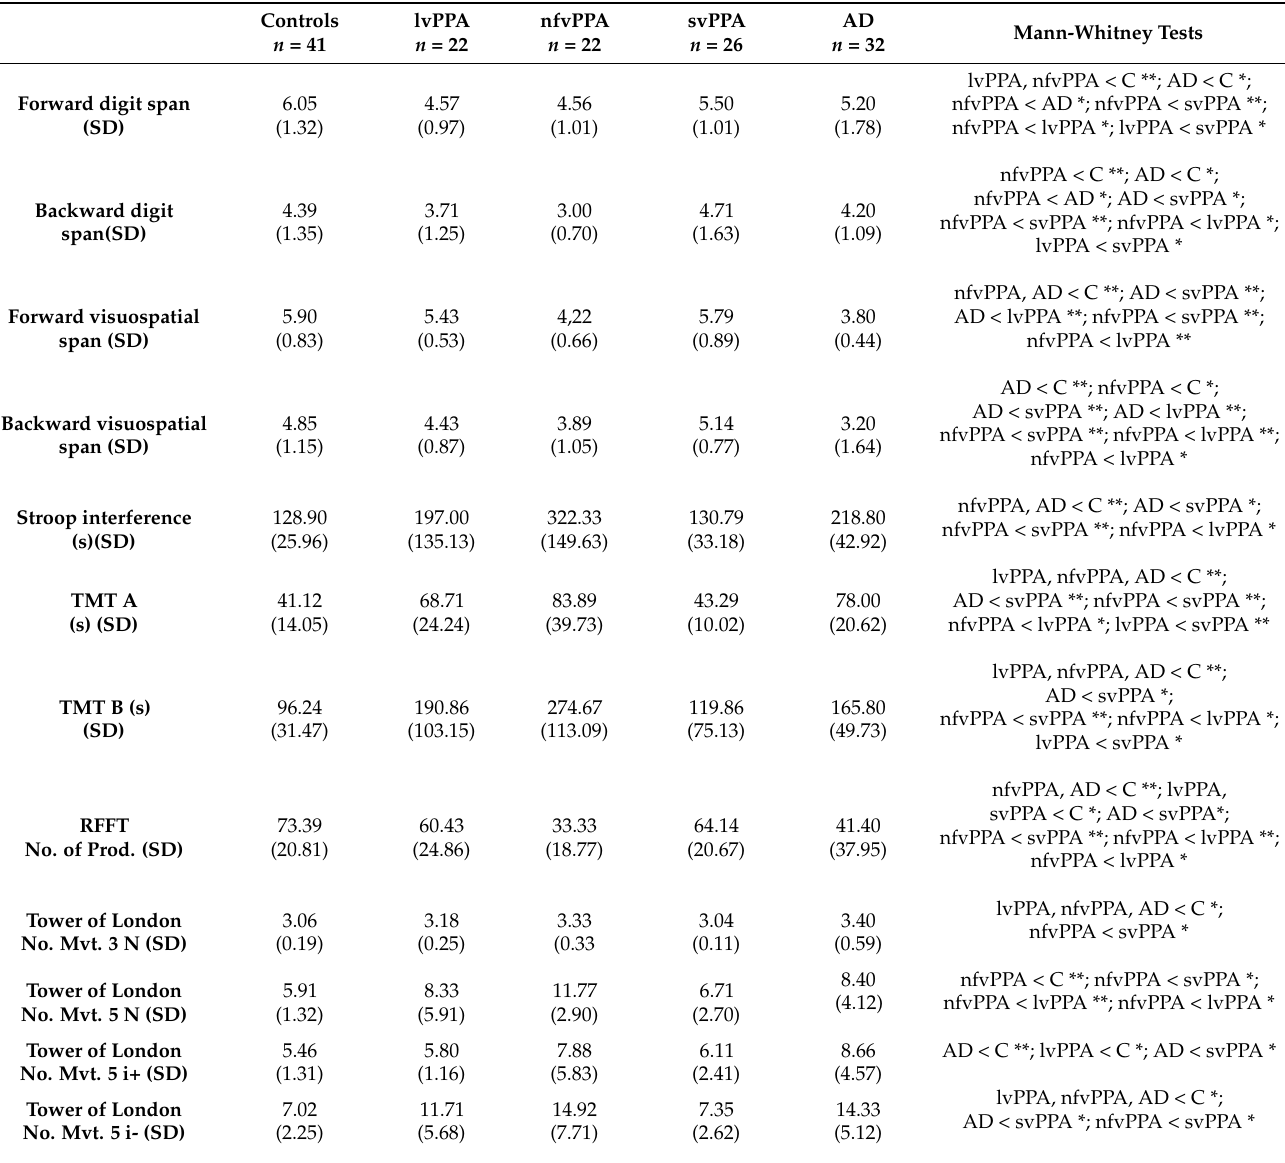
Table 2. Mean of raw scores (and standard deviation) and comparison of groups in tests assessing executive